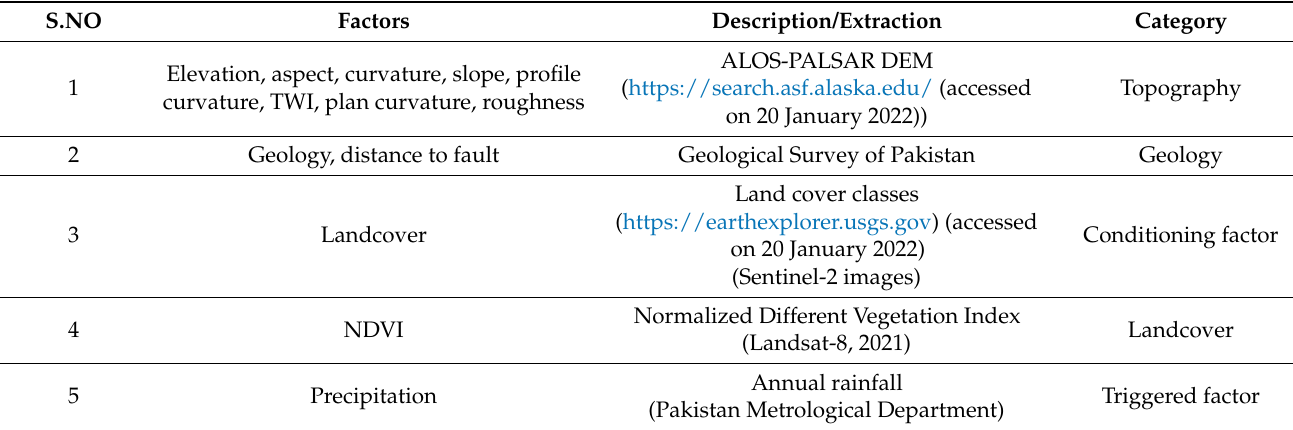
Table 1. Information on landslide conditioning factors.